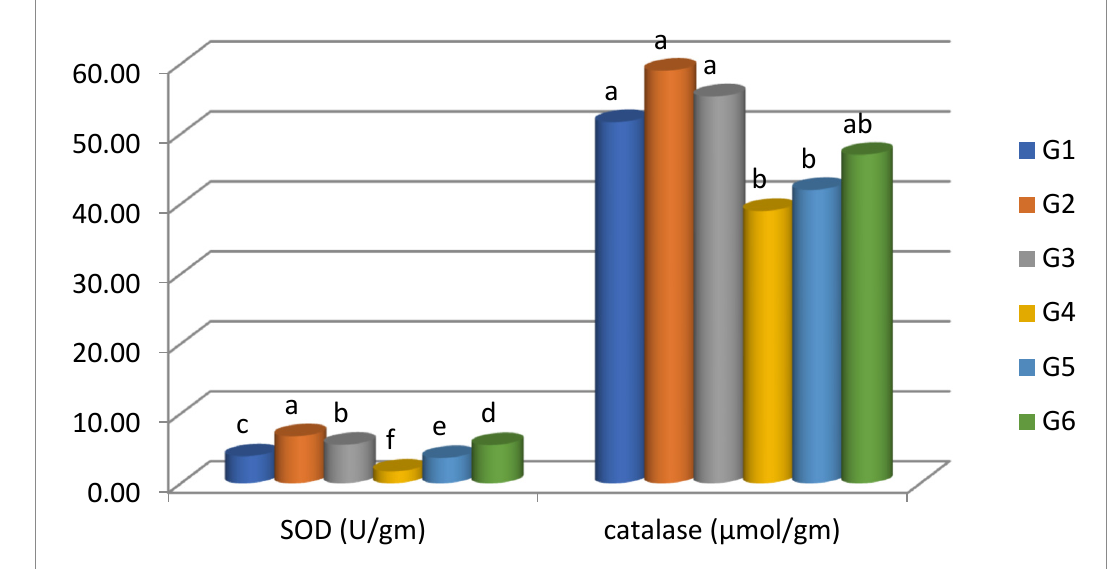
Figure 4. SOD and CAT activities of Nile tilapia fed supplemented diets in formic acid and carvacrol post-challenge with P. putida . Bars represent the arithmetic mean; error bars are SD. Different letters indicate significant differences ( p < 0.05, Tukey’s multiple comparison tests) among groups.